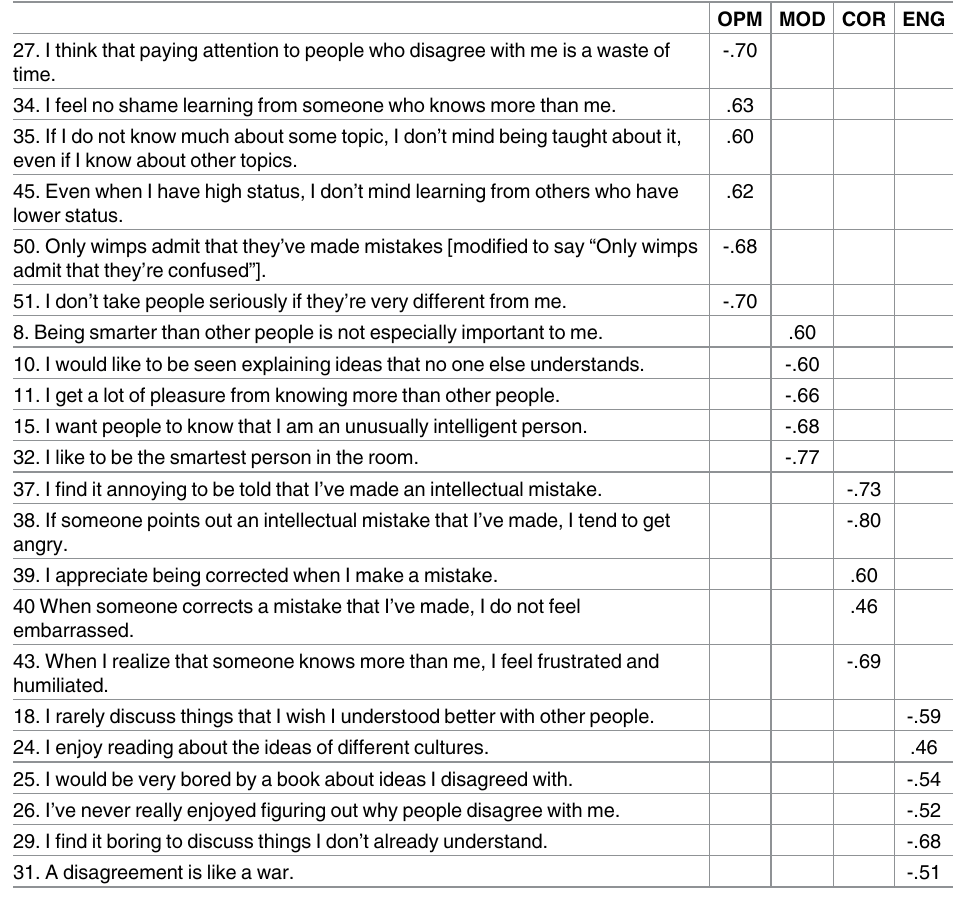
Table 7. The final 4-factor solution from study